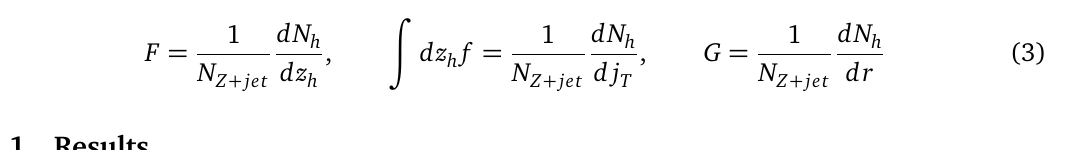
Figure 1: Measured z distributions at inclusive jets (middle) and ATLAS γ -jets (right) [ 8 ] .